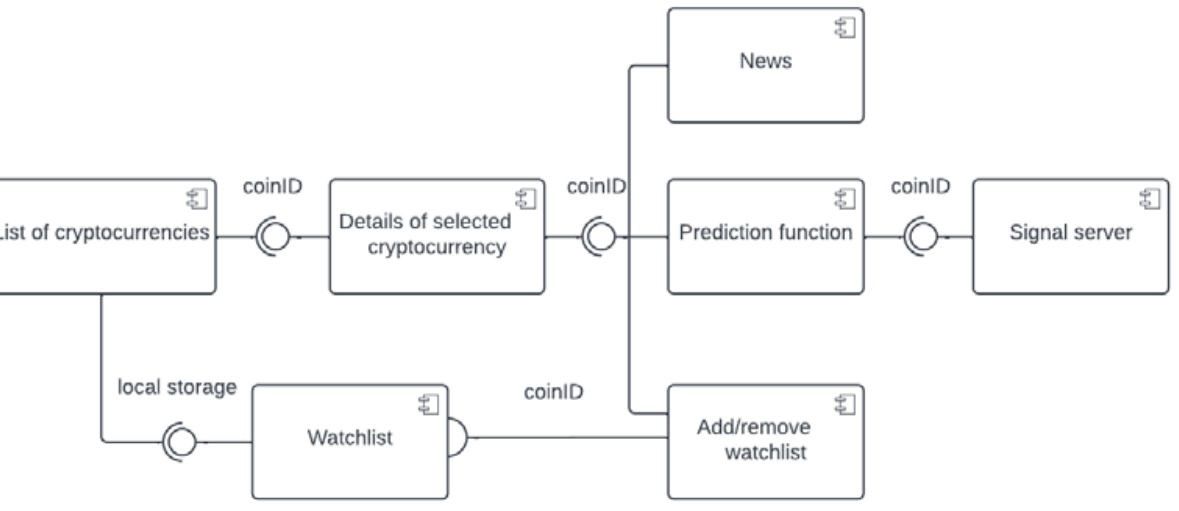
Figure 1. Component diagram of the proposed system.